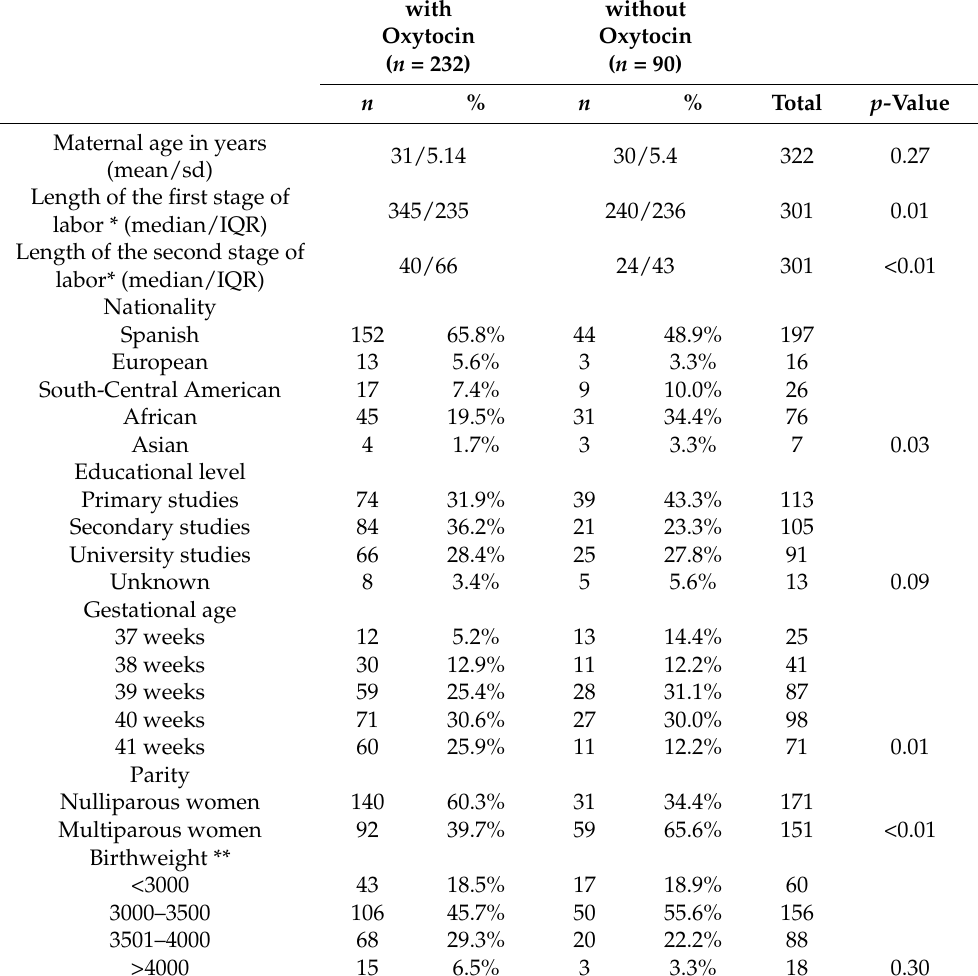
Table 1. Maternal and neonatal